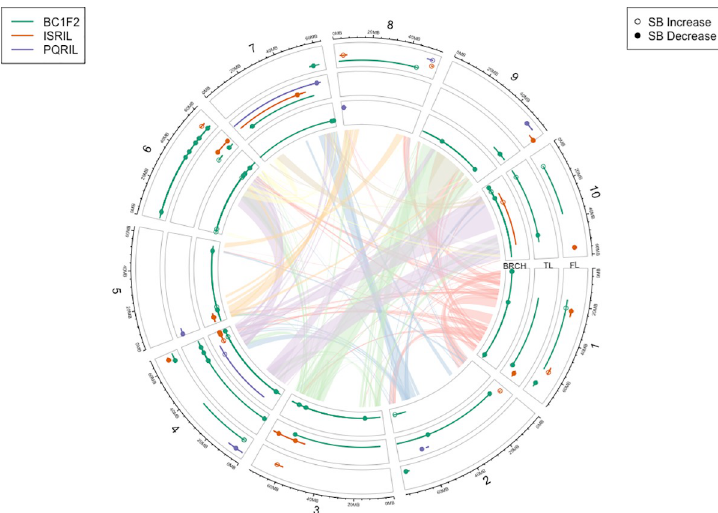
Fig 5. QTL correspondence for flowering time (FL), tillering (TL), and secondary branching (BRCH) in SBSH-BC 1 F 2 , ISRIL and PQRIL populations in physical distance. Links are the duplication events in sorghum